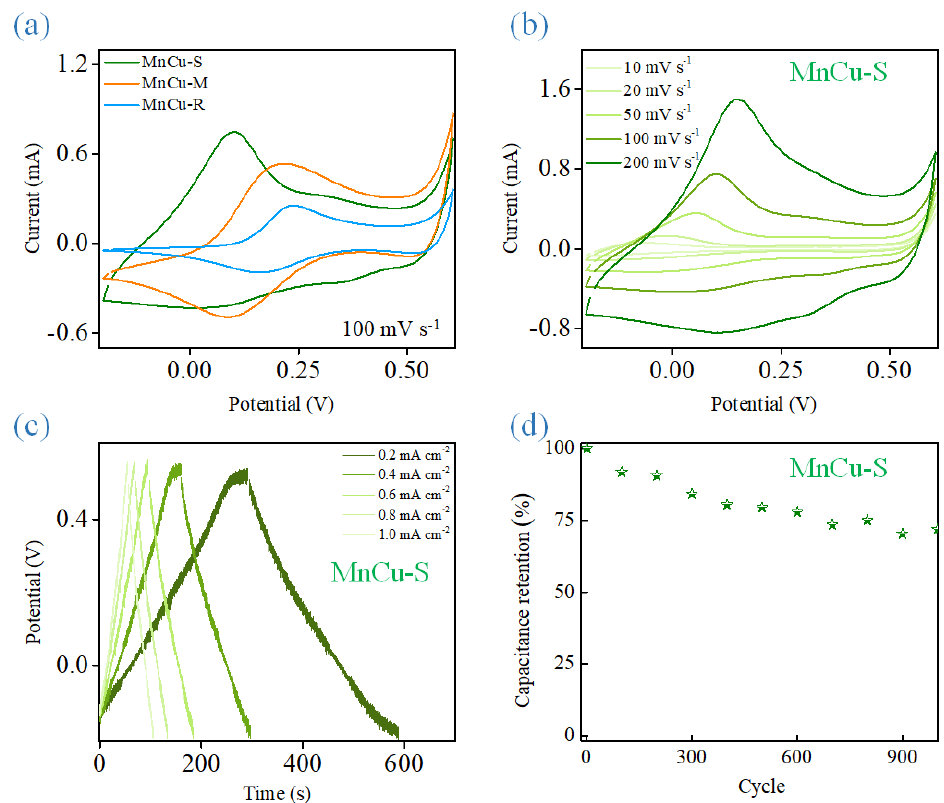
Figure 9. ( a ) CV curves of MnCu-R, MnCu-M, and MnCu-S ( b ) CV curves, and ( c ) galvanostatic charge/discharge curves of MnCu-S in 1 M KOH at different scan rates and current densities. ( d ) Cyclic stability of MnCu-S in 1 M KOH.